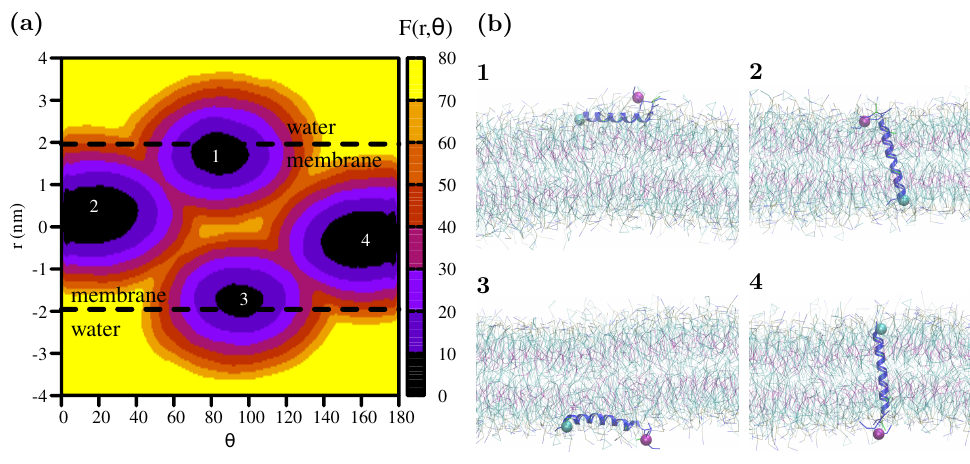
Figure 4. ( a ) The free-energy surface for the Fis1(TA) peptide’s insertion into the membrane. The color scheme represents the relative free energy F ( r , θ ) with respect to the minimum as indicated by the color bar. Four distinct minima represent the monotopic (1 and 3) and bitopic (2 and 4) orientations of the peptide in the membrane. ( b ) Representative snapshots of the peptide in each case. Amino- terminus and carboxyl-terminus are marked by cyan- and purple-colored